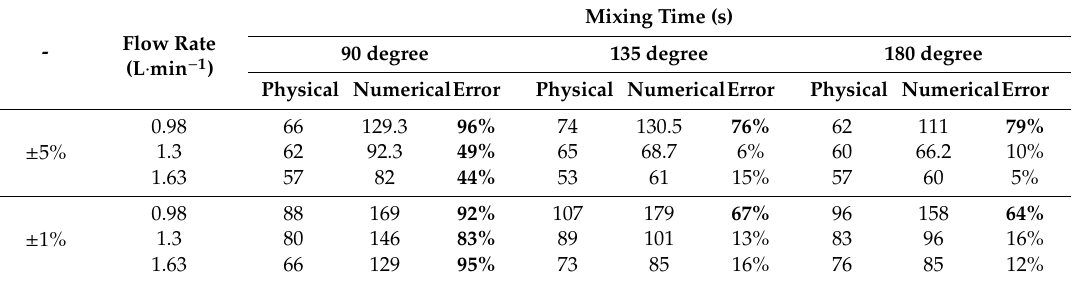
Table 3. Comparison of the tracer homogenization in the physical and mathematical modelling. Figure 12. Measured mixing time with various radial-plug angles in the experiment: ( a ) ±5% homogenization and ( b ) ±1% homogenization.